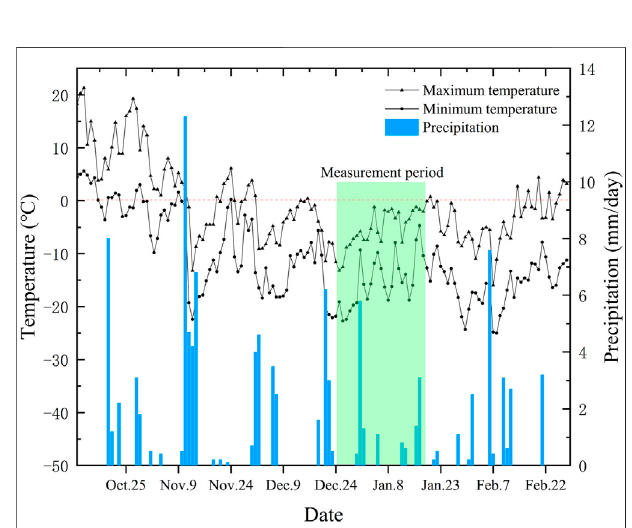
FIGURE 2 | Temperature and precipitation during the measurement period.The temperatureand precipitation during themeasurementperiod are shown in Figure 2 . The red dotted line shows a temperature of 0 ° C. The temperature during the measurement period was always below 0 ° C. It ensures that freeze-thaw cycles did not occur, making the snow powdery rather than sticking to each other A total of 8 snowfall events occurred, with maximumprecipitationof5.8 mm, whichprovidedsuf fi cientsnowsources for fi eld measurements. This satis fi es another factor of the snowdrift: